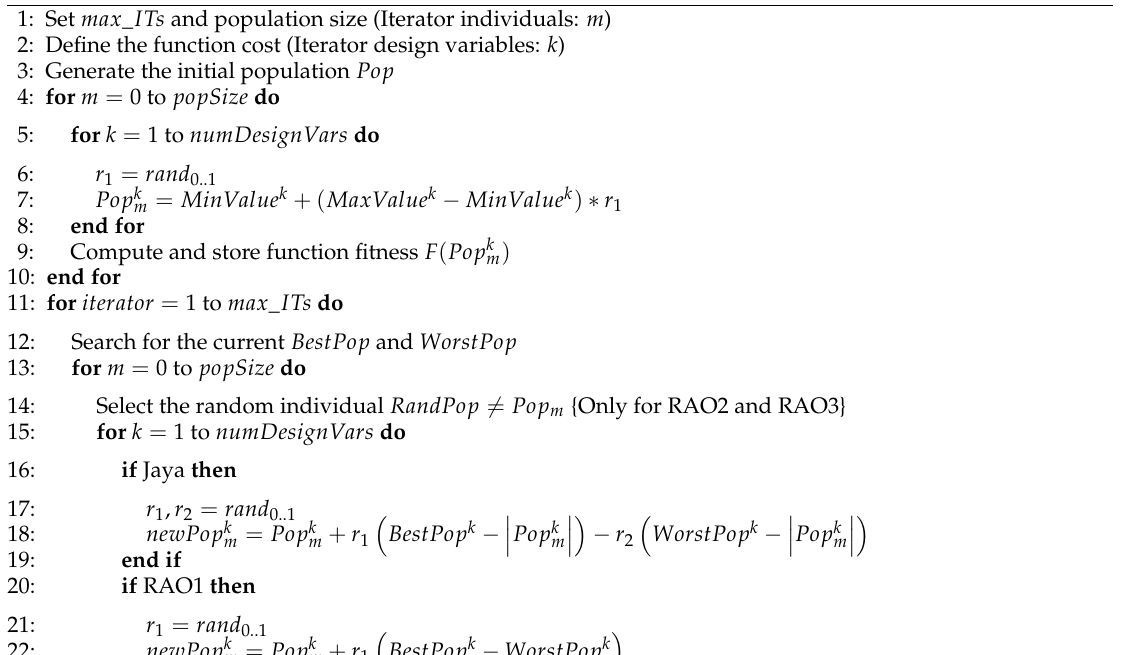
Algorithm 1 Jaya and Rao